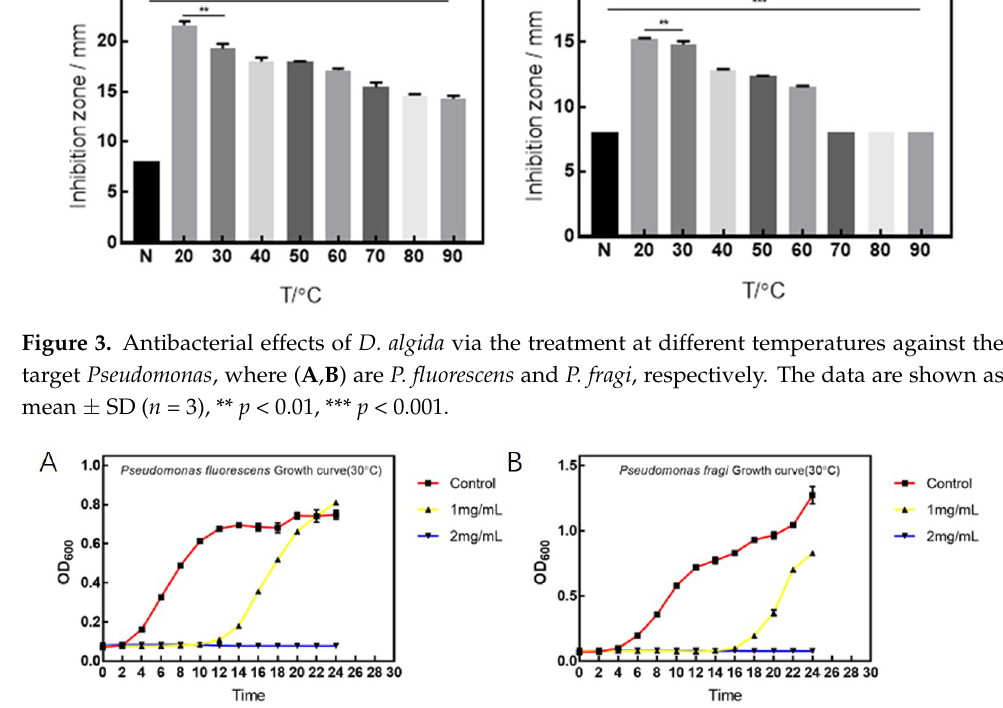
Figure 4. Antibacterial effects of D. algida when the used CFS are with different concentrations against the target Pseudomonas , where ( A , B ) are P. fluorescens and P. fragi , respectively. The data are shown as mean ± SD ( n =